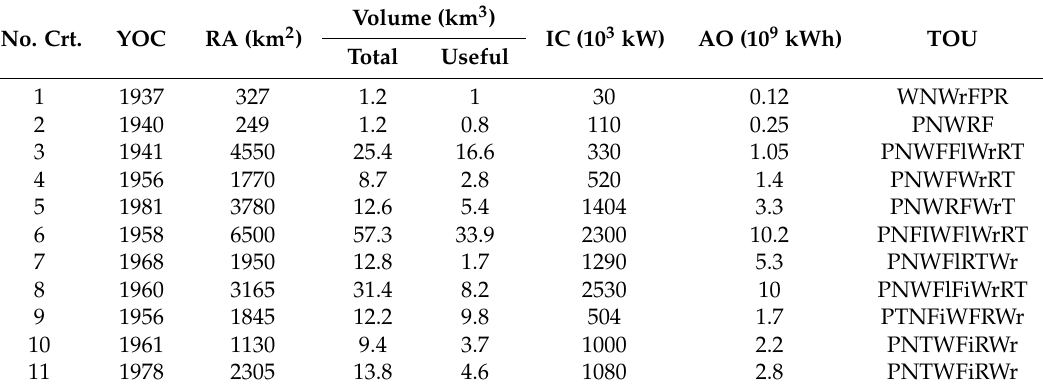
Table 1. The main characteristics of reservoirs from the Volga-Kama cascade [24,25] (the numbers in the first column correspond to the reservoirs from Figure